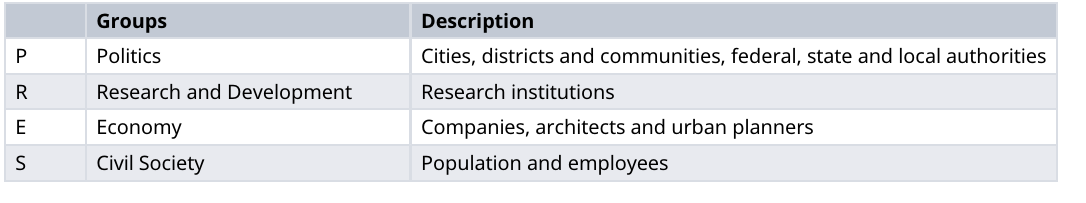
Table 2. Groups of stakeholders and assigned causes and drivers according to IE.F and Roland Berger. 24